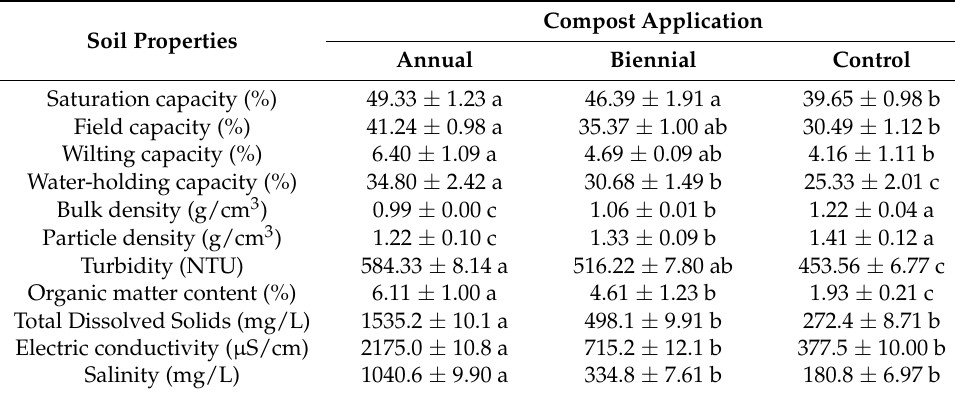
Table 1. Soil physical and chemical properties of experimental plots in Year